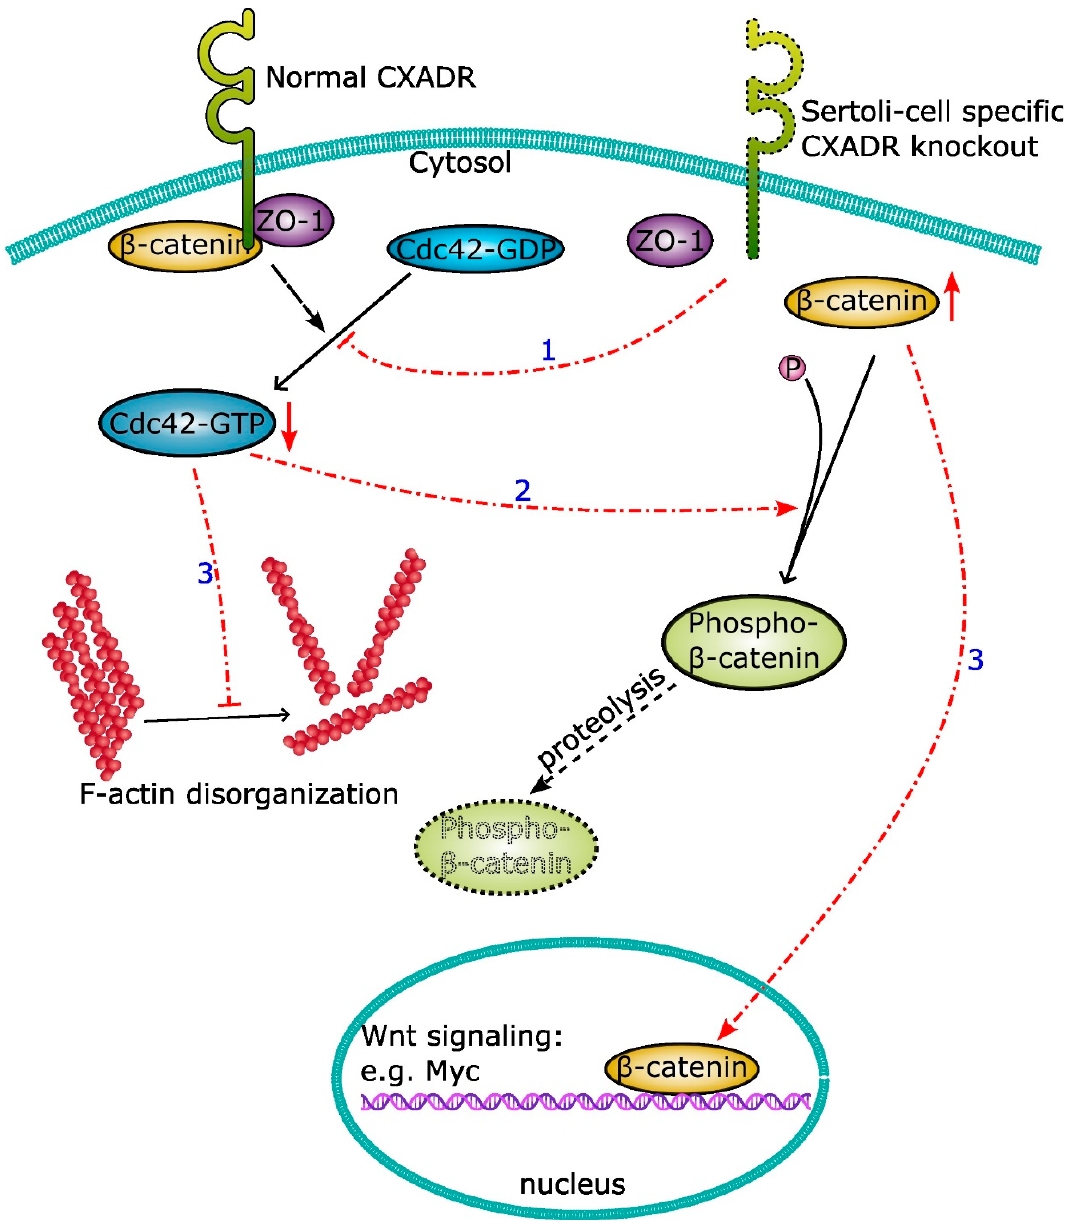
Figure 1. A schematic drawing illustrating the validated regulatory mechanisms of Sertoli cell-specific CXADR-mediated junction dynamics. In normal physiological conditions, Sertoli cell-specific CXADR physically interacts with ZO-1 and β -catenin, which is required for the activation of Cdc42, thus maintaining the organization of F-actin at cell junctions. Sertoli cell-specific CXADR knockout disrupts the distribution of ZO-1 and β -catenin (1). Absence of Sertoli cell-specific CXADR causes a switch of Cdc42 from its active form (Cdc42-GTP) to the inactive form (Cdc42-GDP) (2). Inactivation of Cdc42 results in disruption of the F-actin organization and suppression of β -catenin phosphorylation (3). SC-CXADR knockout also promotes β -catenin translocation from the cytosol to nucleus, hence altering the transcription of its downstream targets such as Myc (3). Caruso et al. generated a cardiac-restricted, doxycycline-regulated, CXADR overex-